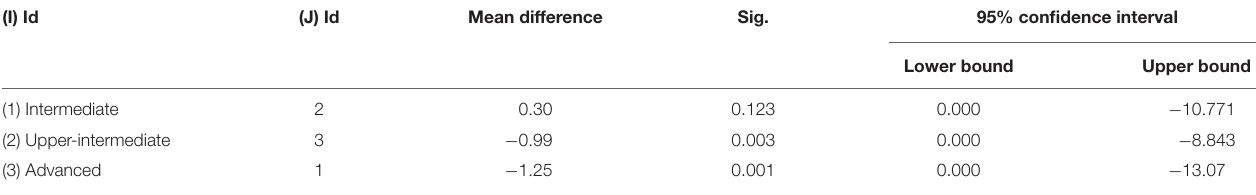
TABLE 11 | Multiple comparison of